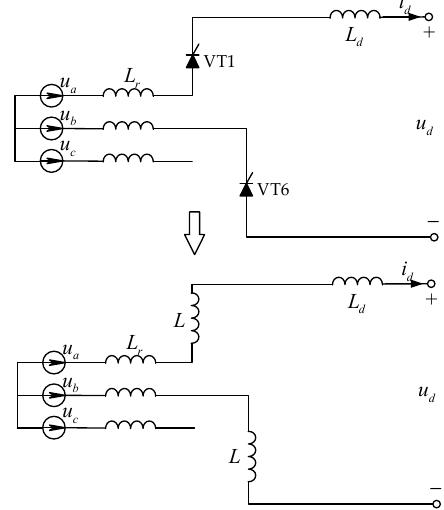
Figure 5. L/C switch equivalent circuit when VT1 is in conduction state.